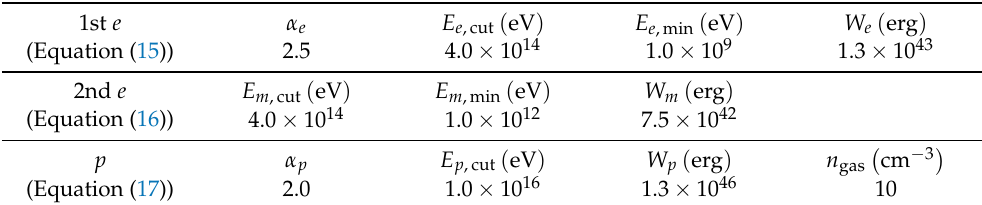
Figure 3. Left panel : The two-component leptonic scenario for the head region. The dark green solid line is the synchrotron radiation of the power-law type electrons, and the red dash–dotted and dotted lines are the synchrotron and IC radiation of the Maxwellian-type electrons, respectively. The salmon points on the left are the radio data from Kothes et al. [10], and the bright pink butterfly plot is from the observation of Chandra in Ge2021. The recent NuSTAR measurement at 3–20 keV is also shown in cerulean [38]. The brown upper limit of the GeV band comes from the Fermi-LAT observation of the head region [18], while the cyan and magenta TeV data points and orange butterfly plot on the right are from AS γ [17], LHAASO [1], and HAWC [16], respectively. The GeV–TeV observations are not involved in the fitting, since most of them are spatially coincident with the tail region, and they are shown for reference only. Right panel : The lepto-hadronic scenario. The dark green solid line represents the synchrotron radiation of electrons, and the red dash–dotted line represents gamma-ray radiation from π 0 decay. Table 4. Fitting parameters of the two-component leptonic scenario and lepto-hadronic scenario, corresponding to Figure 3. The former comprises the PWN electron component (first row) plus the Maxwellian type (second row), and the latter comprises the PWN electron component (first row) plus proton component (third